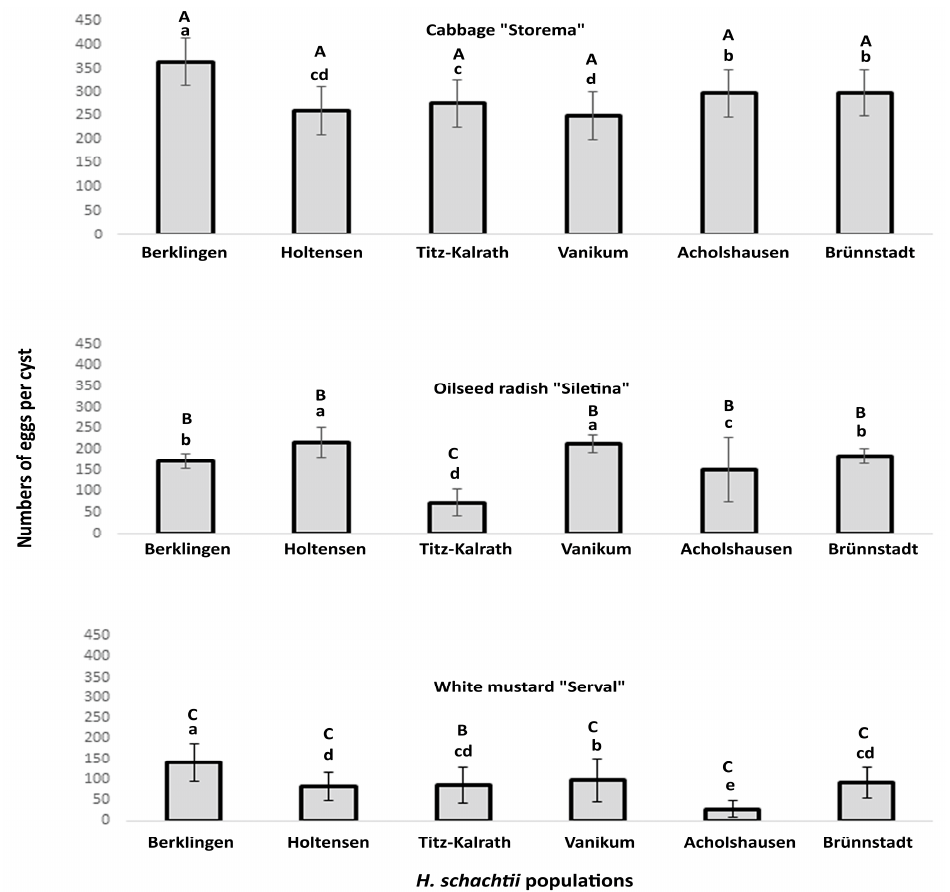
Figure 3. Numbers of eggs per propagated cyst of six populations of H. schachtii reared for two nematode generations on the susceptible cabbage ( Brassica oleracea L., cv. Storema) or susceptible oilseed radish ( Raphanus sativus L., cv. Siletina) or resistant white mustard ( Sinapis alba L., cv. Serval). For each two-week seedling, 450 J2 were added and incubated under greenhouse conditions (20/16 ◦ C for a 16/8 h day/night cycle) for three months. The counting was for eggs contained in the cysts extracted from the loess substrate by floatation on MgSO 4 solution (1.28 specific density). (a,b,c,d,e) compare the mean numbers of egg/cyst ratio among populations reared on the same plant species. (A,B,C) compare the mean numbers of egg/cyst ratio of the same population reared on the three plant species. Di ff erent le tt ers indicate signi fi cant di ff erences (Wilcox´s test, p < 0.05, n = 8).